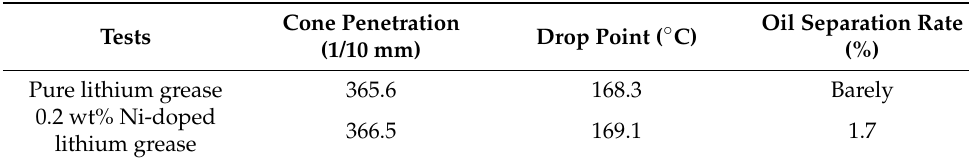
Table 2. The physical characterization